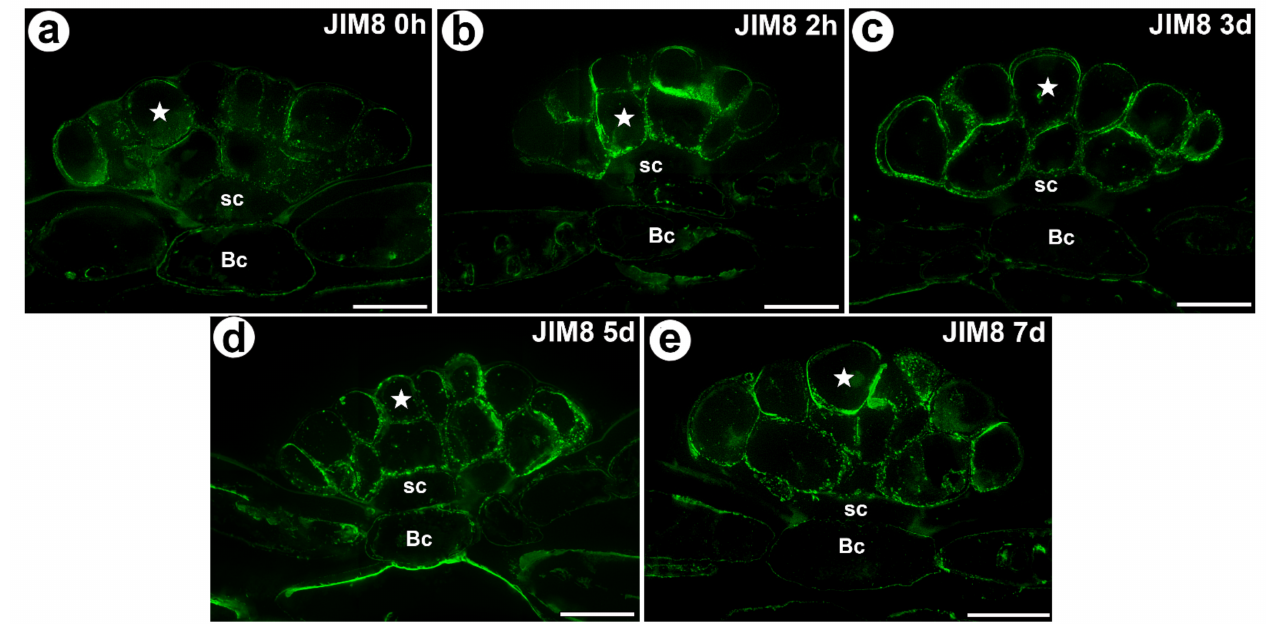
Figure 3. The arabinogalactan proteins (labeled with JIM8) that were detected in a D. muscipula trap. ( a ) Immunolabeling of AGP with JIM8 that were detected in the gland from an unfed trap: secretory cell (star), stem cell (sc), bar 20 µ m. ( b ) The arabinogalactan proteins (labeled with JIM8) that were detected in a gland two hours after feeding: secretory cell (star), stem cell (sc), basal cell (Bc), bar 20 µ m. ( c ) Immunolabeling of AGP with JIM8 that were detected in a gland three days after feeding: secretory cell (star), stem cell (sc), basal cell (Bc), bar 20 µ m. ( d ) Immunolabeling of AGP with JIM8 that were detected in a gland five days after feeding: secretory cell (star), stem cell (sc), basal cell (Bc), bar 20 µ m. ( e ) Immunolabeling of AGP with JIM8 that were detected in a gland seven days after feeding: secretory cell (star), stem cell (sc), basal cell (Bc), bar 20 µ m. All photos are maximum projections from